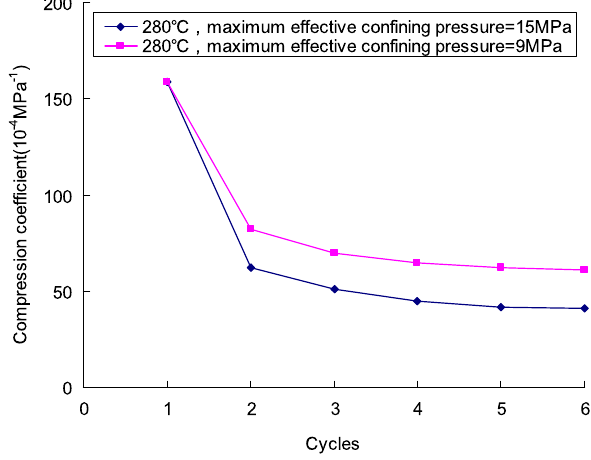
Fig. 10 Effects of the maximum effective confining pressure on the compression coefficient of the rock after cycle (the effective confining pressure is 9